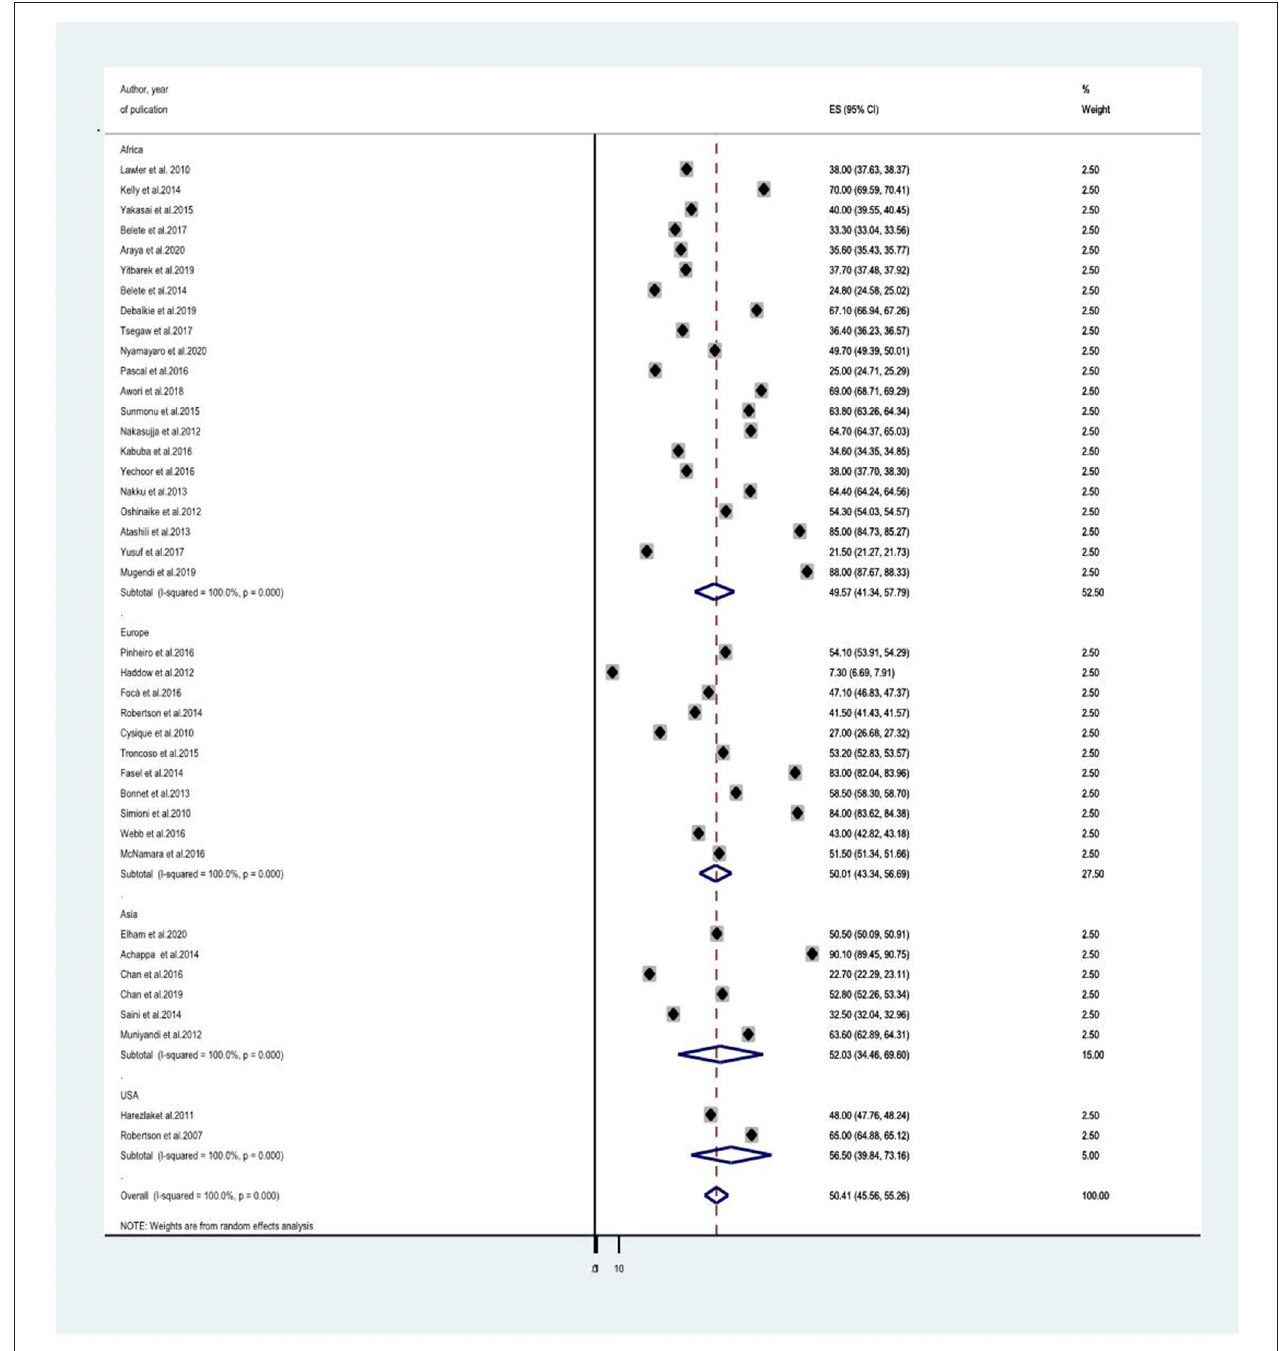
FIGURE 3 | A subgroup analysis for the prevalence of HIV associated neurocognitive disorders based on country of study origin.